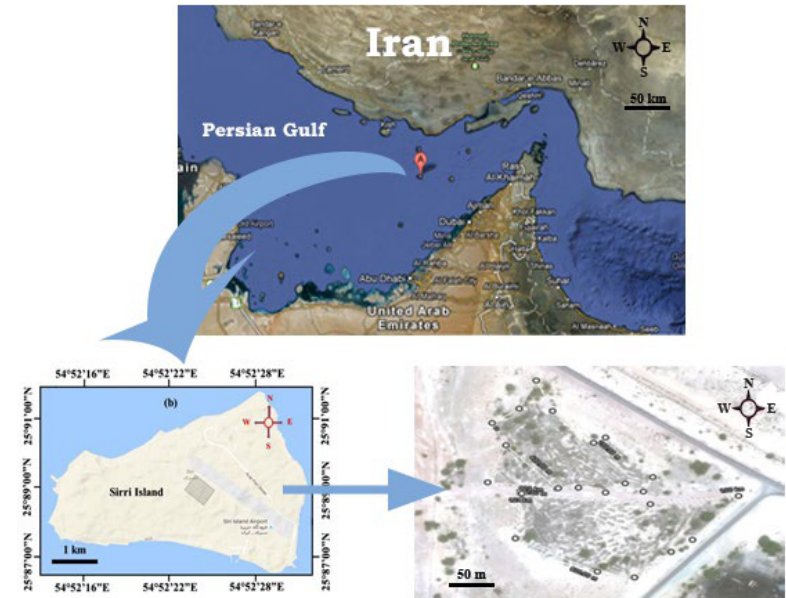
Fig. 1: The petroleum sludge depot region in Sirri Island located in the Persian Gulf of Iran